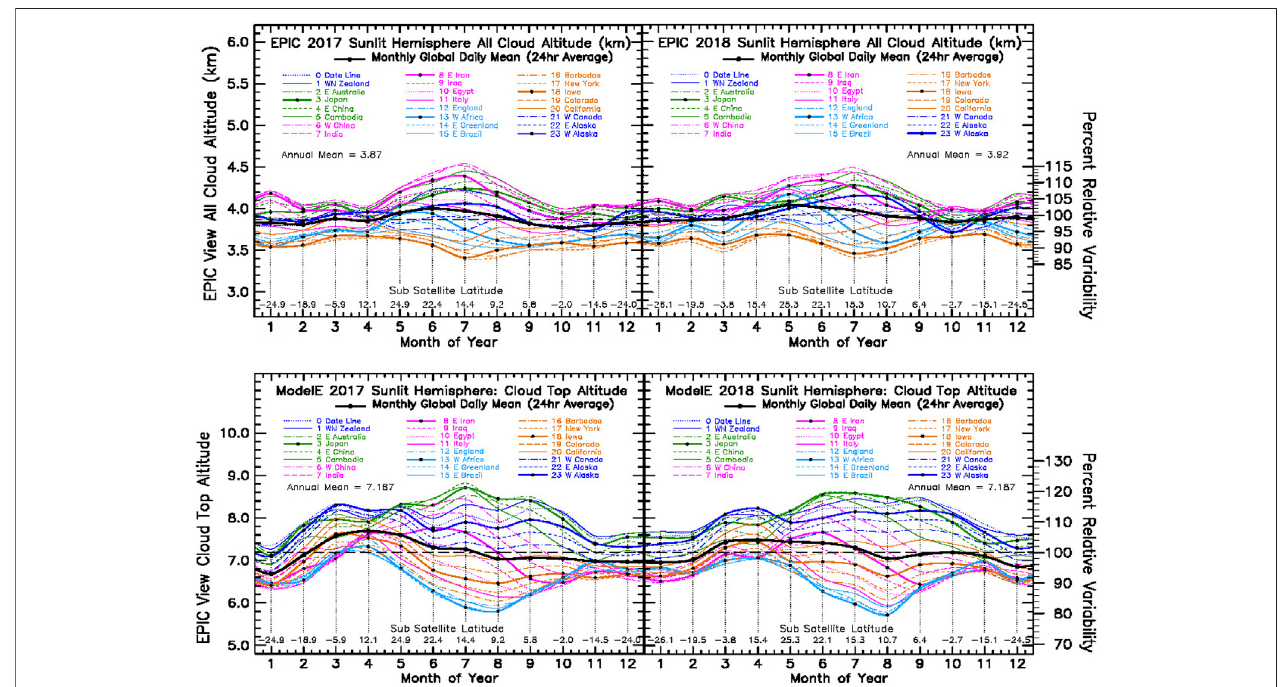
FIGURE7|TopPanel :All-cloudcloud-topaltitudefromEPICCompositeanalysisresultsfortheyear2017 (TopLeft) andfortheyear2018 (TopRight) . Bottom Panel : All-cloud cloud-top altitude (km) from GISS ModelE2 climate simulations for the year 2017 (Bottom Left) and 2018 (Bottom Right) sampled using the Sunlit Hemisphere Sampling (SHS) simulator and employing the DSCOVR Ephemeris viewing